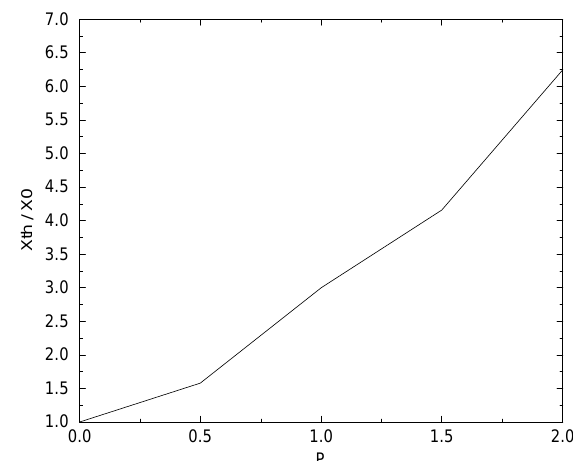
FIG. 5. The factor of increasing the TMCI threshold versus parameter (cid:80) to 5 MV (cid:121) m, aperture and wavelength of RF equal to 10 cm (the designed bunch length is approximately the same), b function equal to 600 m, the synchrotron tune equal to 0.01, and the injection energy is 3 TeV. The 12.5 m quadrupole is needed to produce the betatron